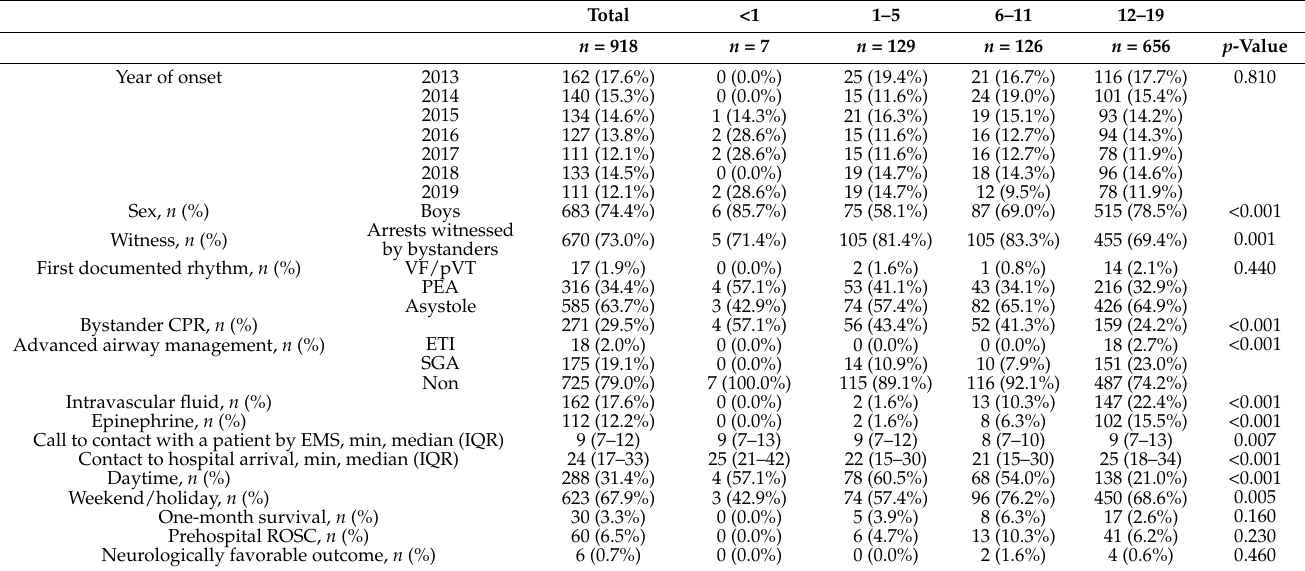
Table 1. Patient characteristics and outcomes of traumatic out-of-hospital cardiac arrests after traffic accidents by age group.